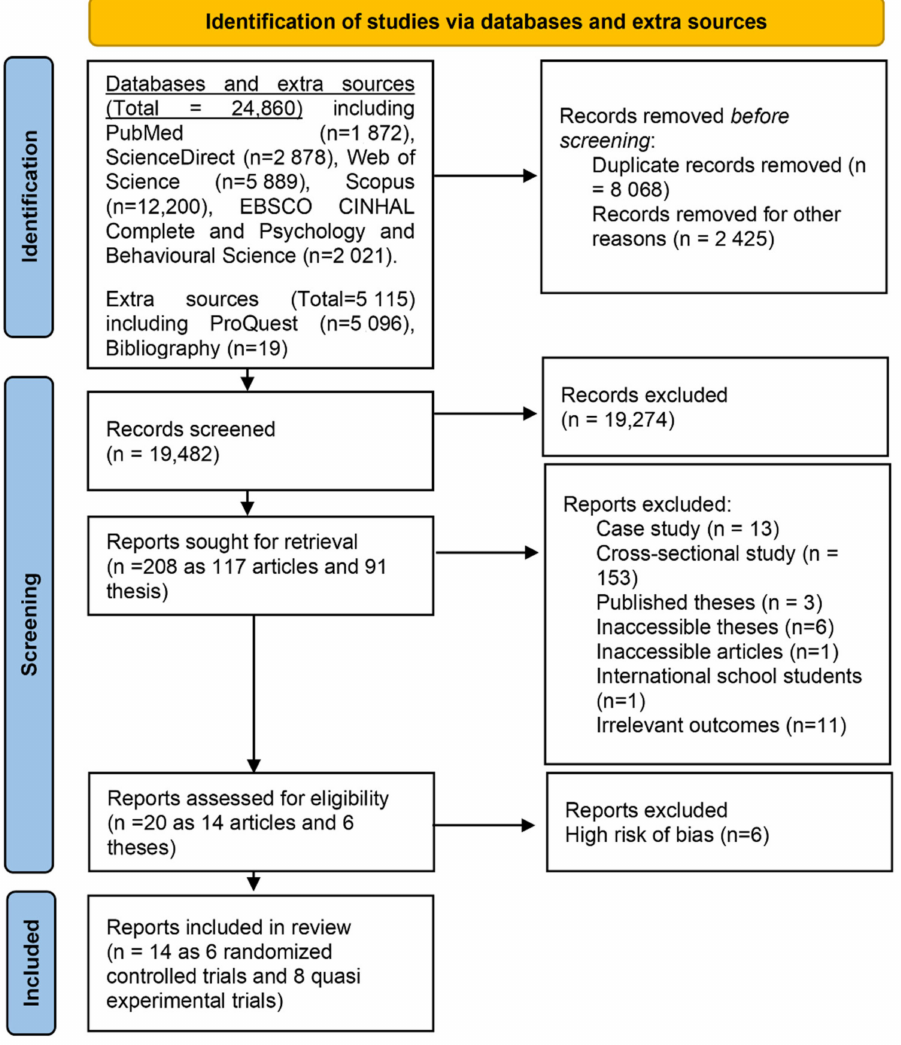
Figure 1. Flowchart of the methodology of the current study according to PRISMA.